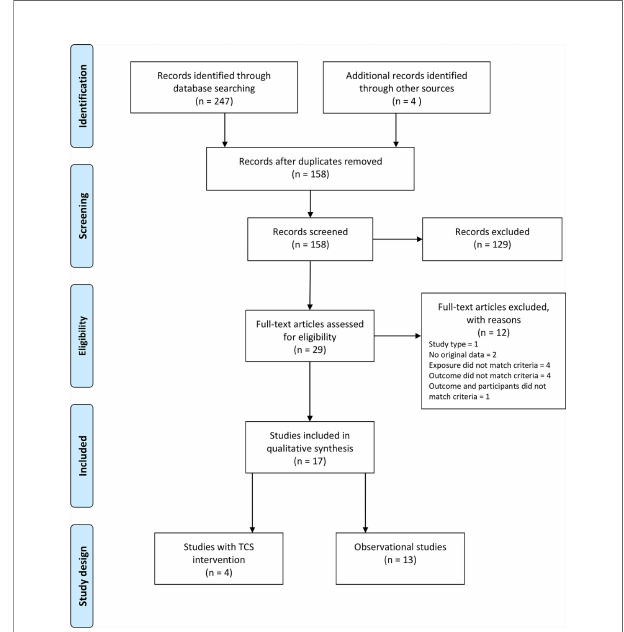
FIGURE 3 | PRISMA diagram of selection of eligible studies (4 studies of triclosan intervention and 13 observational studies) included in the search for studies of triclosan exposure and human thyroid